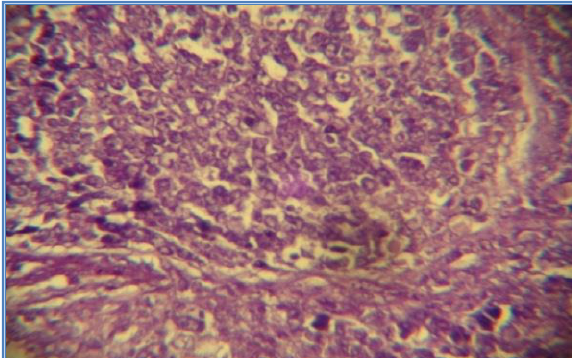
Figure, 3: Cecal tonsil of 1st group after 240 hrs. heat exposure showed moderate cellularity in lamina propria (H and E stain 400X).